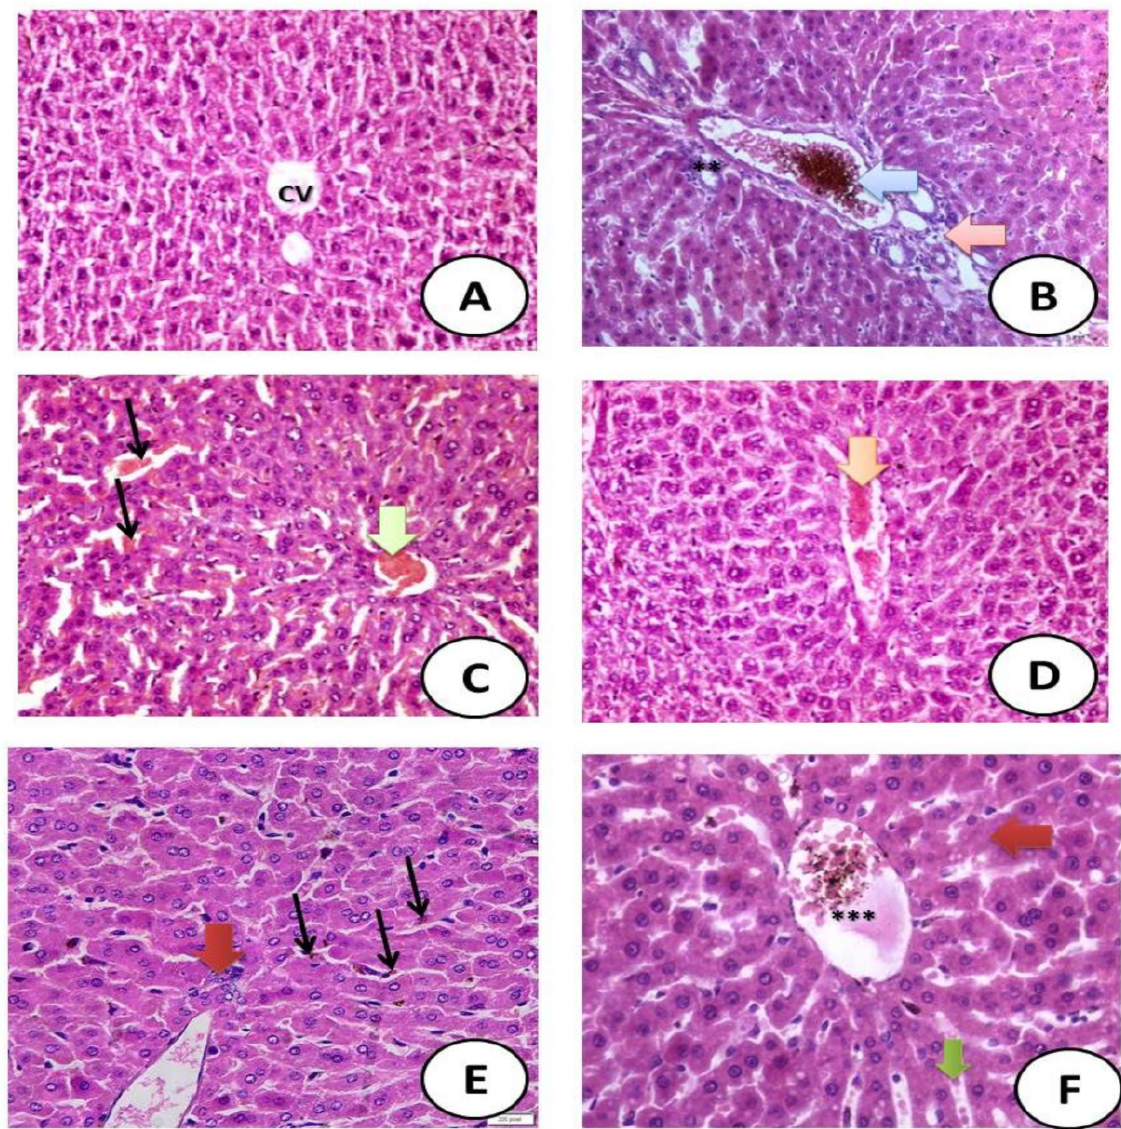
Figure 7. Histological sections. ( A ) Control group showing normal hepatic structure with normal- sized central vein (CV) (H&EX400). ( B ) STZ-treated group showing severe hepatic toxicity in the form of hypertrophy of hepatocytes with appearance of binucleated hepatocytes and increased eosinophilia, granular cytoplasm (Blue arrow) and vesicular nuclei. The portal tract showed dilated irregular portal vein filled with blood, necrotic tissue (red arrow), focal necrosis in some hepatocytes with increased eosinophilia and nuclear disappearance and a ductal reaction (new bile duct formation) at the periphery of the portal tract with periportal fibrosis. ( C ) STZ + Dapg showing moderate hepatotoxicity in the form of partial degeneration of hepatic tissue with necrotic nuclei (black arrow) with bleeding (green arrow) (H&EX400). ( D ) STZ + Zn–Dapg-treated group showing great amelioration in the hepatic structure with mild bleeding and red blood cells (orange arrow) (H&EX400). ( E ) STZ + Cr– Dapg showing very mild toxicity in the form of hypertrophy of hepatocytes with some binucleated hepatocytes (black arrow) that contained mild brown particles of bilirubin indicating biliary tract obstruction (black arrow), focal necrosis of some hepatocytes (red arrow) and mild ductal reactions at the periphery of the central vein (H&EX400). ( F ) STZ + Se–Dapg showing very mild toxicity in the form of hypertrophy of hepatocytes with granular eosinophilic cytoplasm, with mild congested central vein (***), ballooning degeneration in some hepatocytes (red arrow) and focal and single hepatocyte necrosis (green